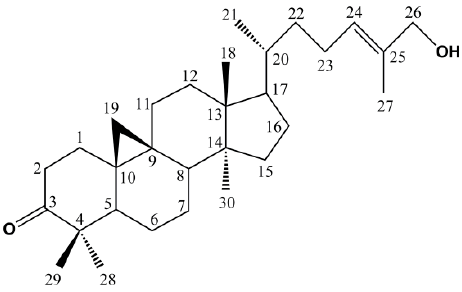
Figure 2. ( a ) 1 H-NMR and ( b ) 13 C-NMR spectral data of 24( E )-cycloart-24-ene-26-ol-3-one.